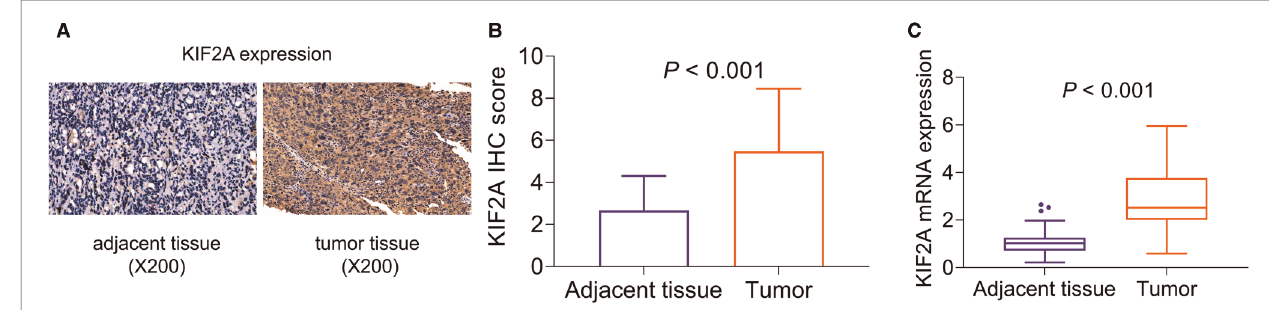
FIGURE 1 | Comparison of KIF2A expression between tumor and adjacent tissue. Stained photographs of KIF2A protein expression ( A ). KIF2A IHC score ( B ) and KIF2A mRNA expression ( C ) in tumor and adjacent tissue of BLBC patients. KIF2A, kinesin family member 2A; IHC, immunohistochemistry; BLBC, basal-like breast cancer.